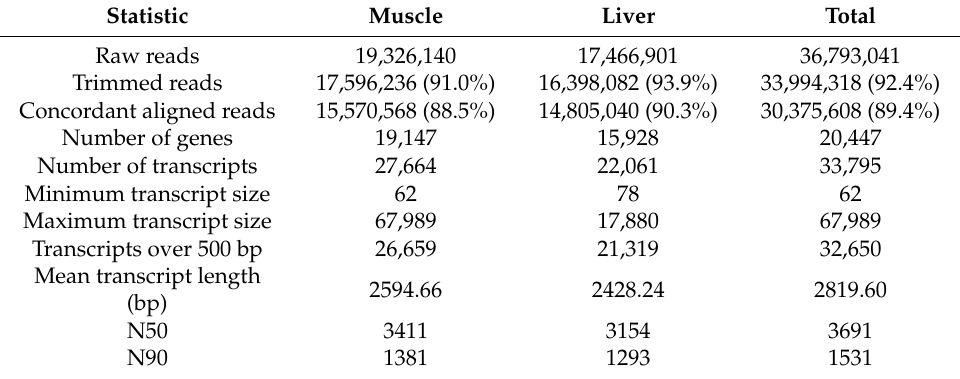
Table 1. RNA-seq and transcriptome assembly